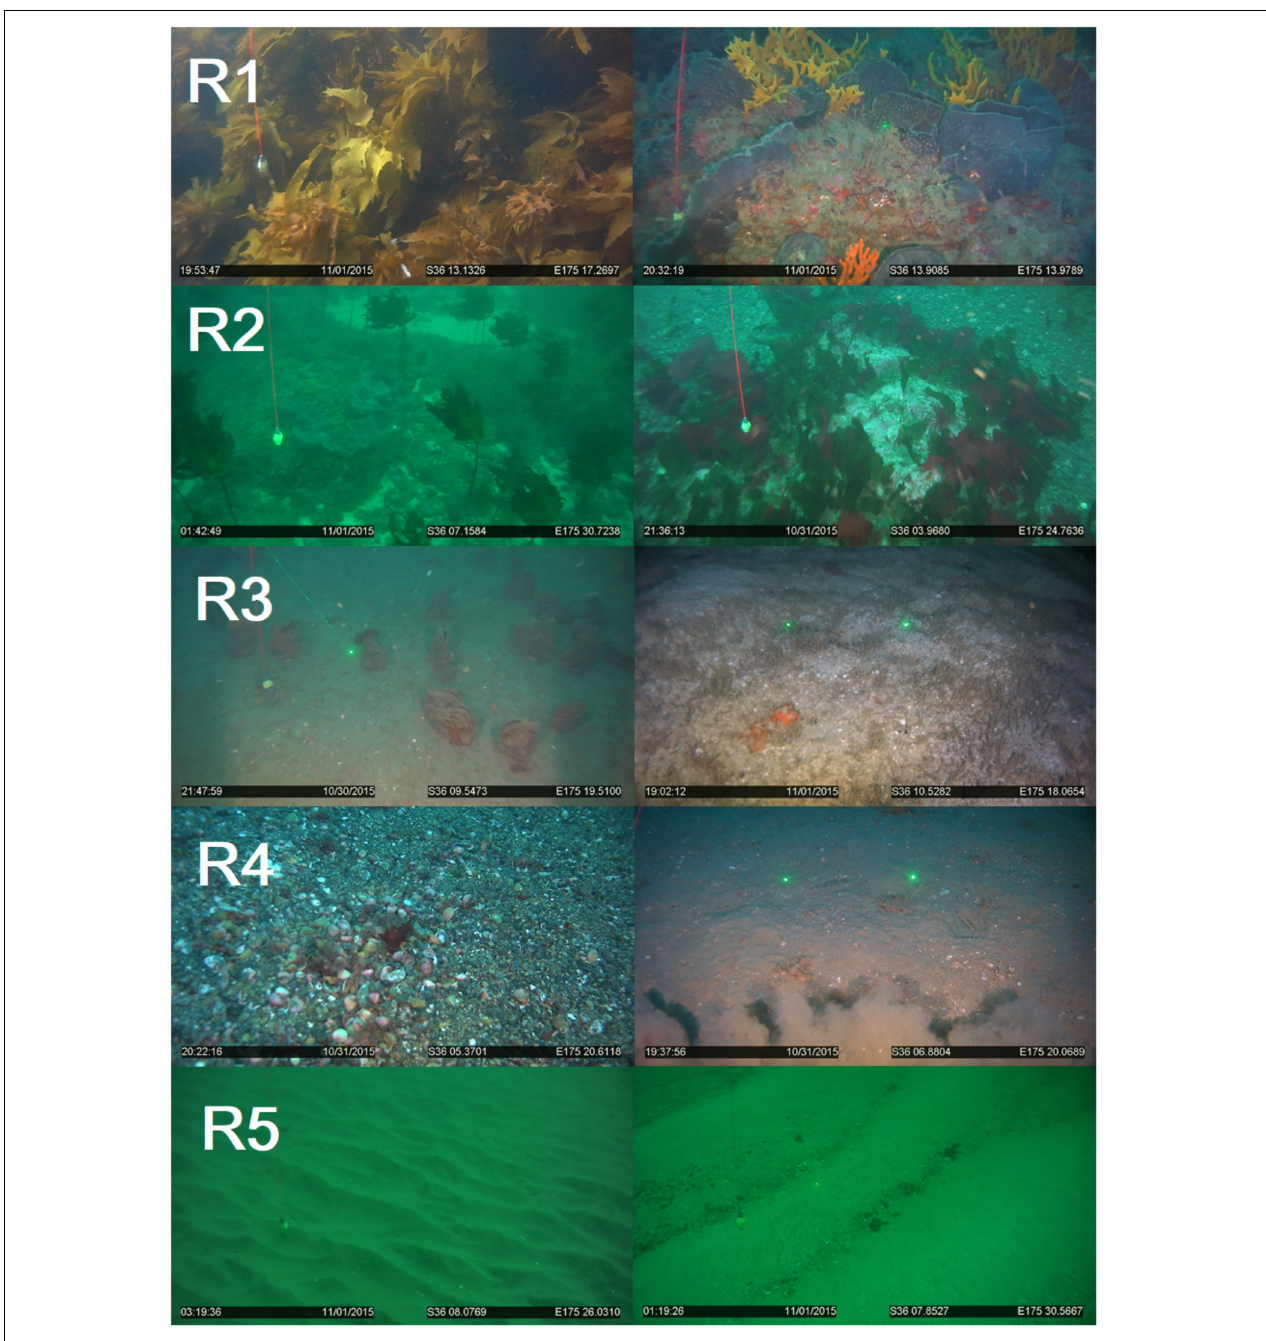
FIGURE 3 | Examples of Biogenic habitat observed from video transect and the assigned ranking